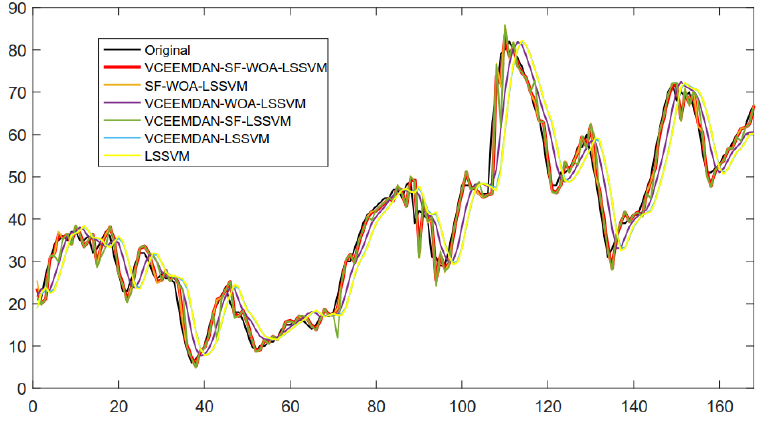
Figure 7. The forecast results of Beijing in the next week (20 April–26 April 2015): to highlight the prediction accuracy of the hybrid model comparing with the models without VCEEMDAN, SF or WOA.